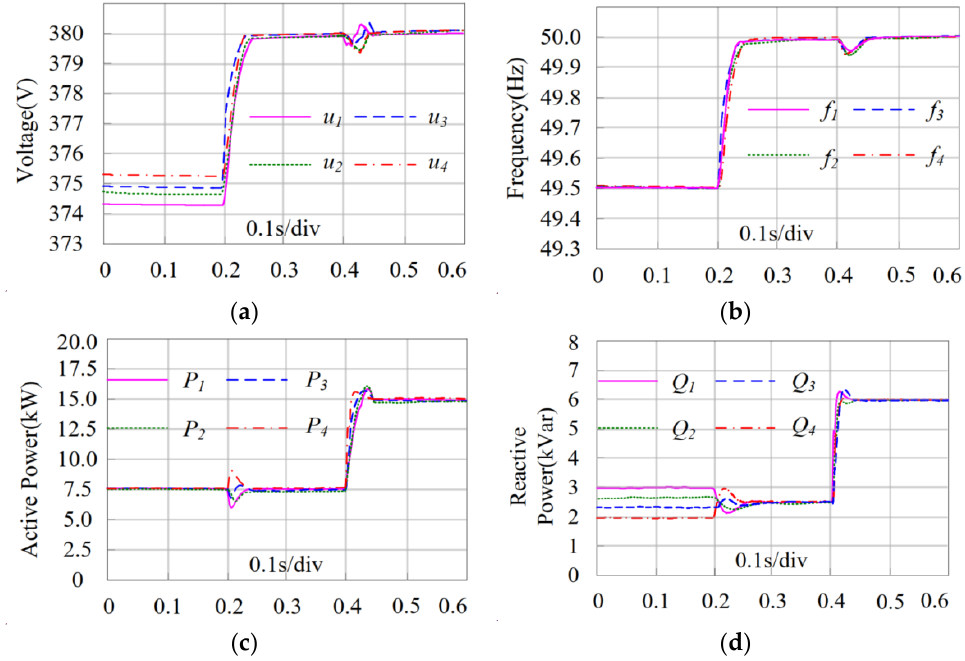
Figure 4. The simulation performance of case study 1.( a )Voltage amplitude;( b )Frequency;( c )Active power;( d )Reactive power.